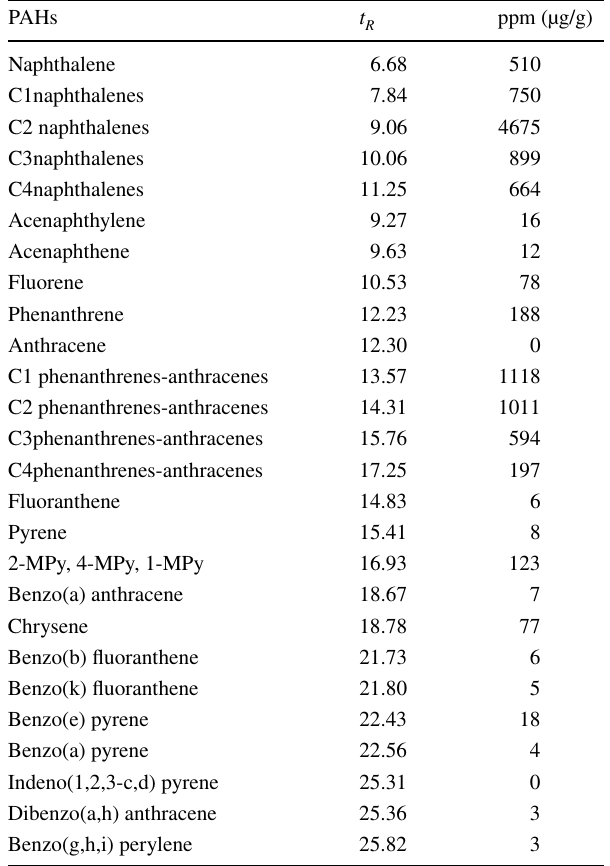
Table 1 Concentration of 16 PAH (alkylated and parents) in the Brut Tunisian Light oil